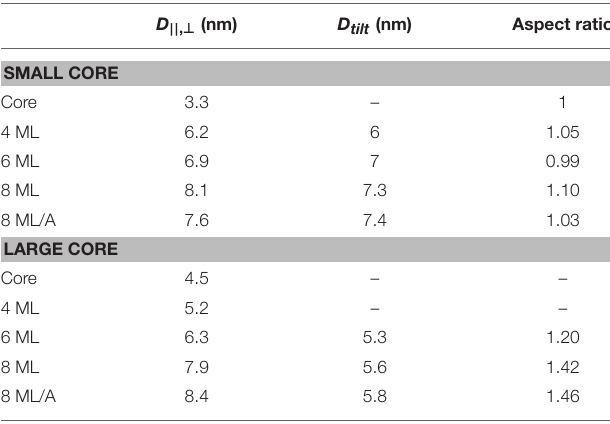
TABLE 3 | The crystallite sizes of the small and large core/shell series as derived from the analysis of the WAXS pattern shown in Figure 4 . D || , ⊥ (nm) D tilt